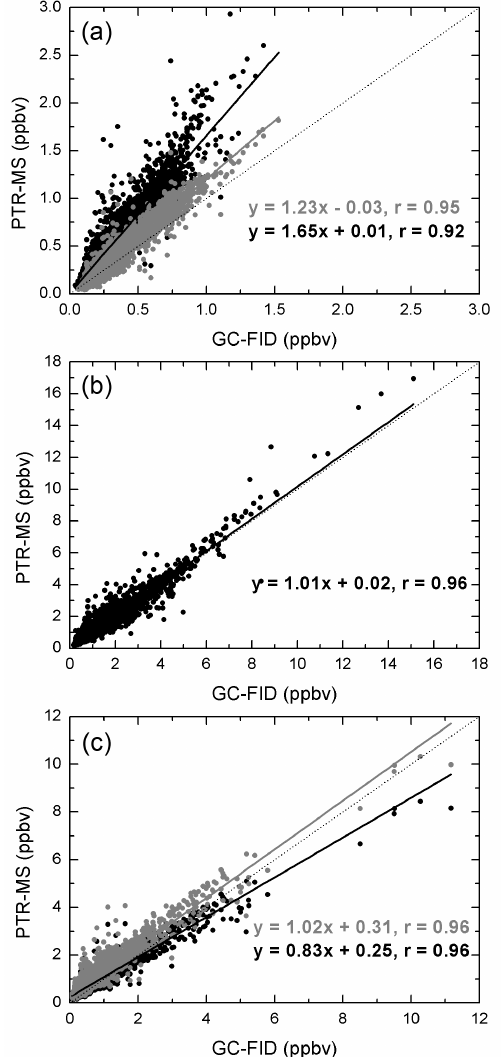
Figure 11. Intercomparison between ambient aromatic hydrocarbon measurements by PTR-MS and by online GC-FID during the field study at MK in Hong Kong: (a) benzene, (b) toluene, and (c) C 2 - benzenes. Original data are plotted in black dots; grey dots represent the corrected data based on Eqs. (6) and (7). Linear regression fits for original and corrected data are indicated by the solid black line and the solid grey line, respectively. Dashed line is the 1 : 1 line for reference.